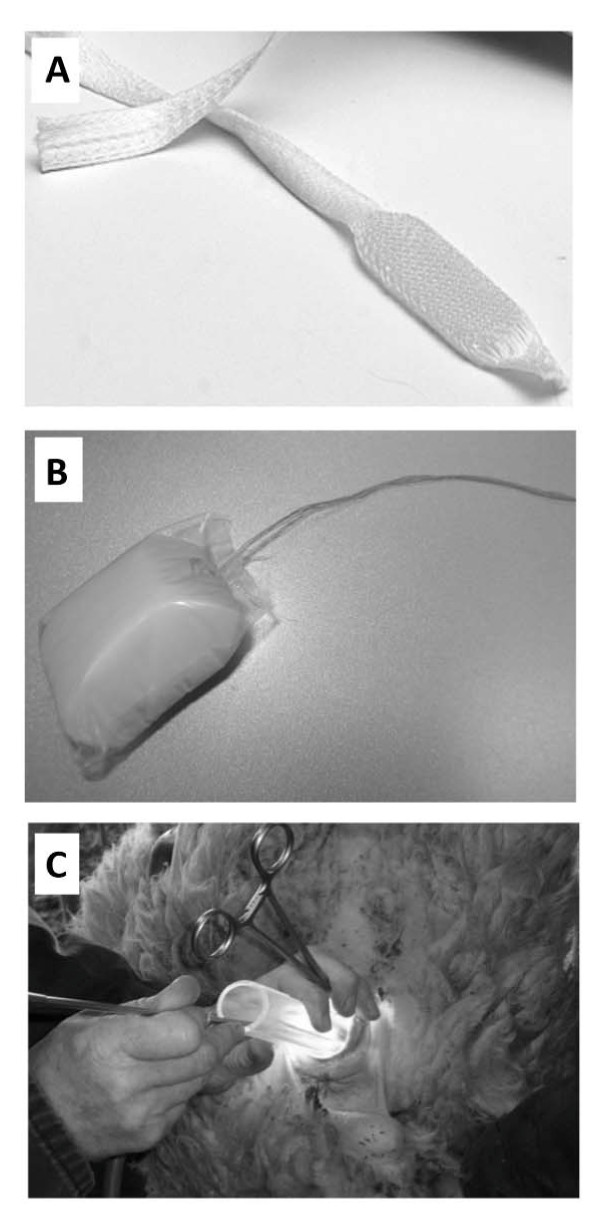
Materials and tools used during Cervidil® treatment and transcervical embryo transfer (TCET) in ewes. (A) Cervidil®® vaginal insert; (B) Manufactured vaginal plugs used to prevent premature loss of Cervidil® inserts from the vaginal canal in ewes; (C) An illuminated vaginal canal of the ewe with a plexiglass vaginoscope inserted. Forceps are used to retract the tissue surrounding the cervical os and the tip of a modified insemination gun is inserted into the cervical opening.